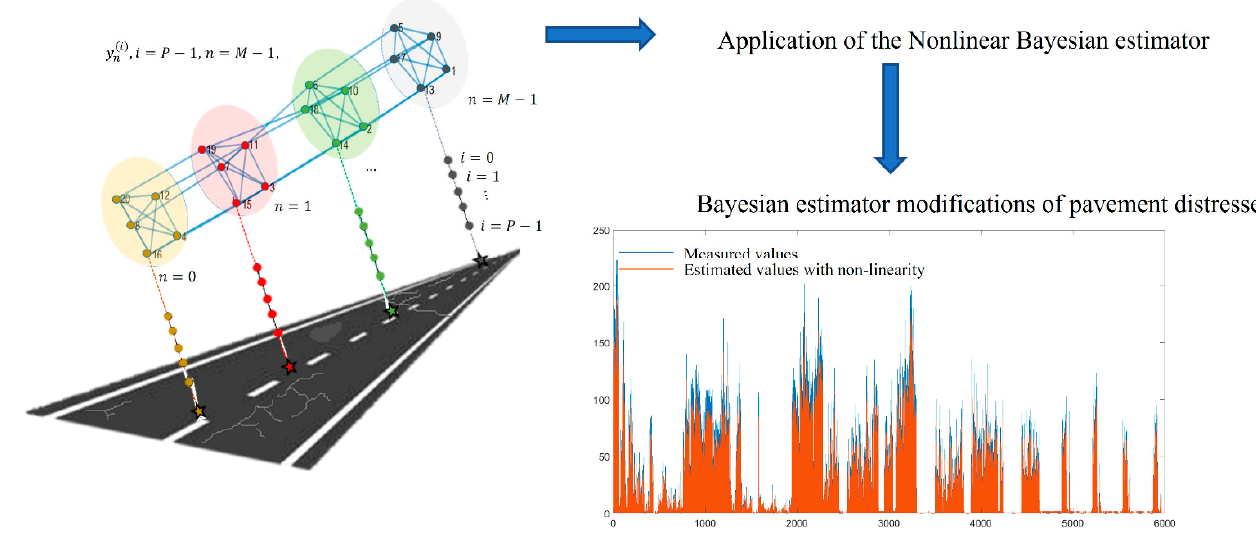
Figure 4. Framework for the pavement distress estimation via SoG processing.